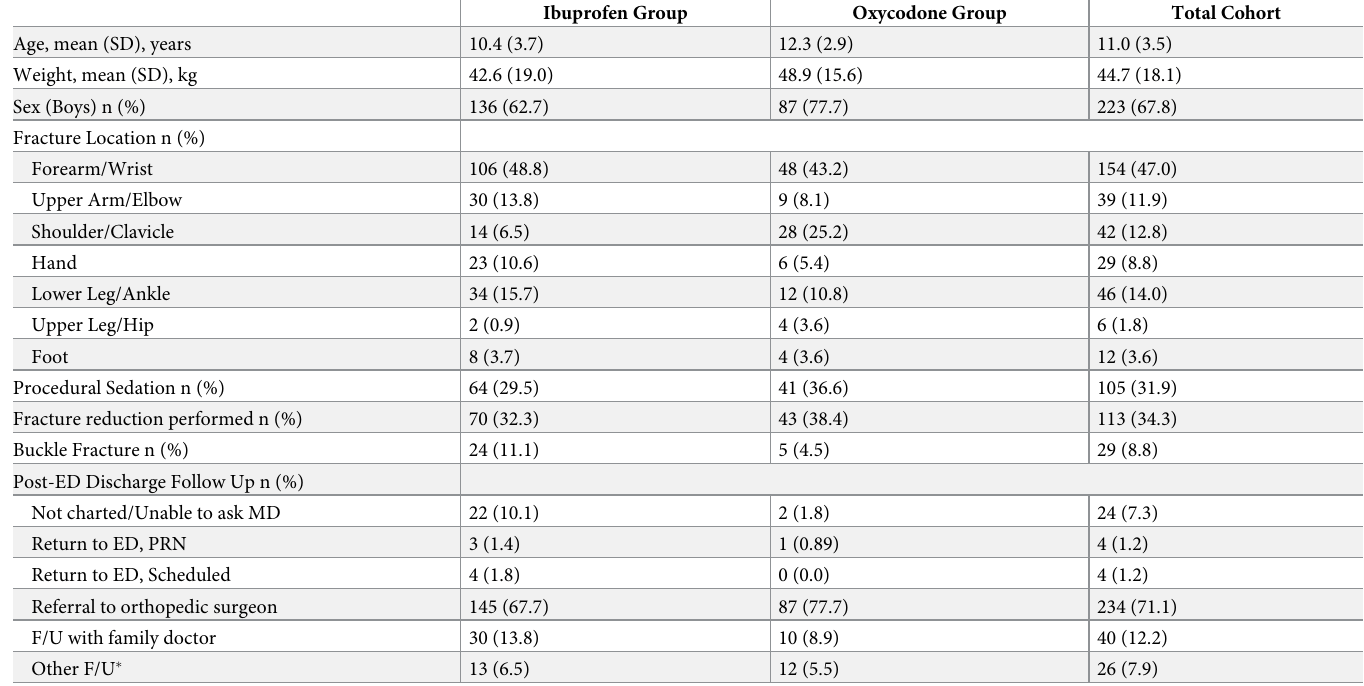
Table 1. Demographics characteristics (n =